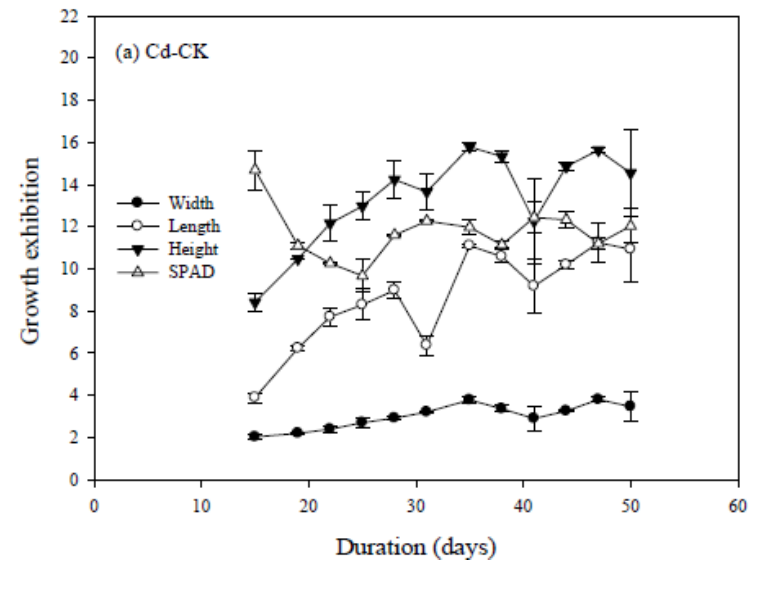
Figure 1. The dynamic exhibition of leaf length, leaf width, plant height, and chlorophyll content (SPAD) of pak choi grown in ( a ) Cd-CK; ( b ) Cd-10; and ( c ) Cd-20. Replicates: n =